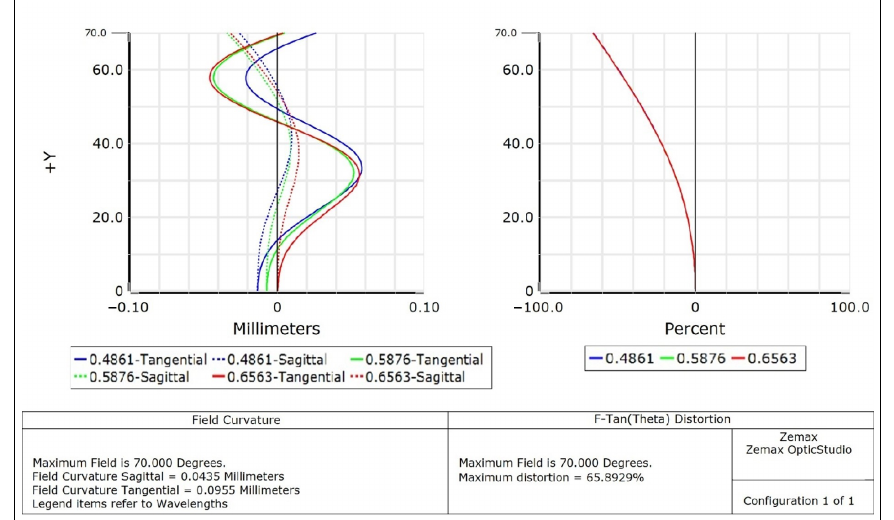
Figure 4. Field curvature and distortion of the optimized